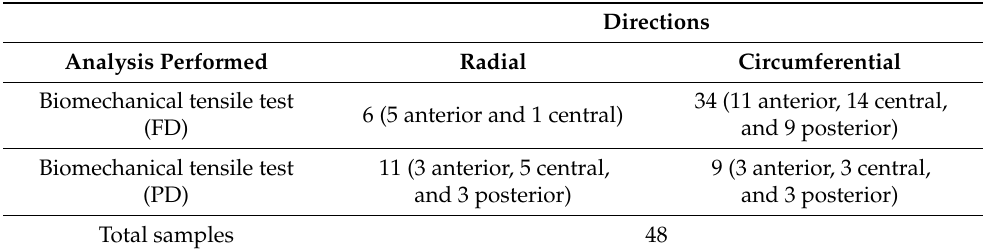
Table 1. The number of each sample utilized for biomechanical tensile test. FD: fully developed; PD: partially